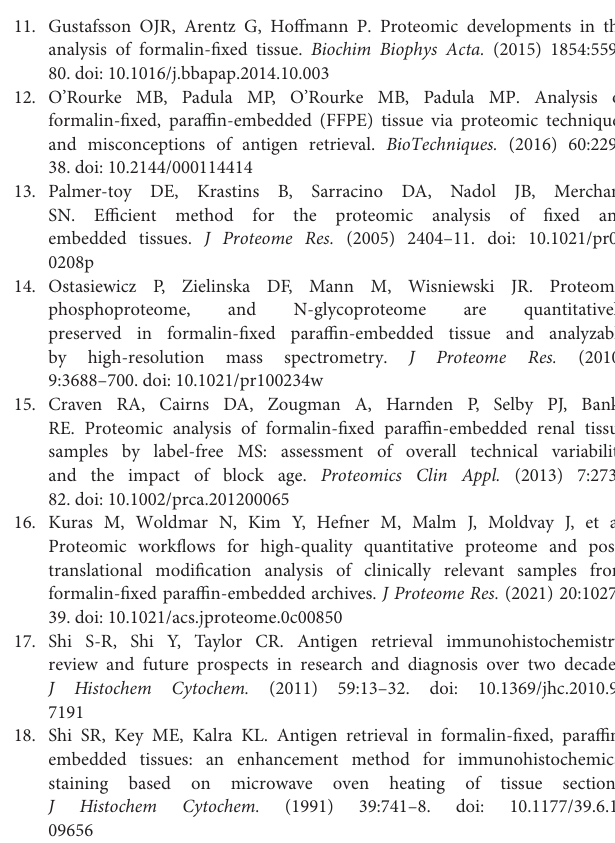
urea-containing buffer [ buffer 2 (urea LB)] (red bars), respectively, according to their cellular component, molecular function and (B) biological process, using the FunRich program. Supplementary Table 5 | Functional classification of all proteins identified after the extraction with the six different buffers [ buffer 1 (Tris-SDS LB), n = 979 proteins; buffer 2 (urea LB), n = 569 proteins; buffer 3 (Tris-SDS-DTT-Glycerol LB), n = 930 proteins; buffer 4 (citrate-SDS LB), n = 921 proteins; buffer 5 (SDS-LB), n = 1086 proteins; buffer 6 (RIPA LB), n = 540 proteins], according to their biological process, molecular function and cellular components, using the FunRich